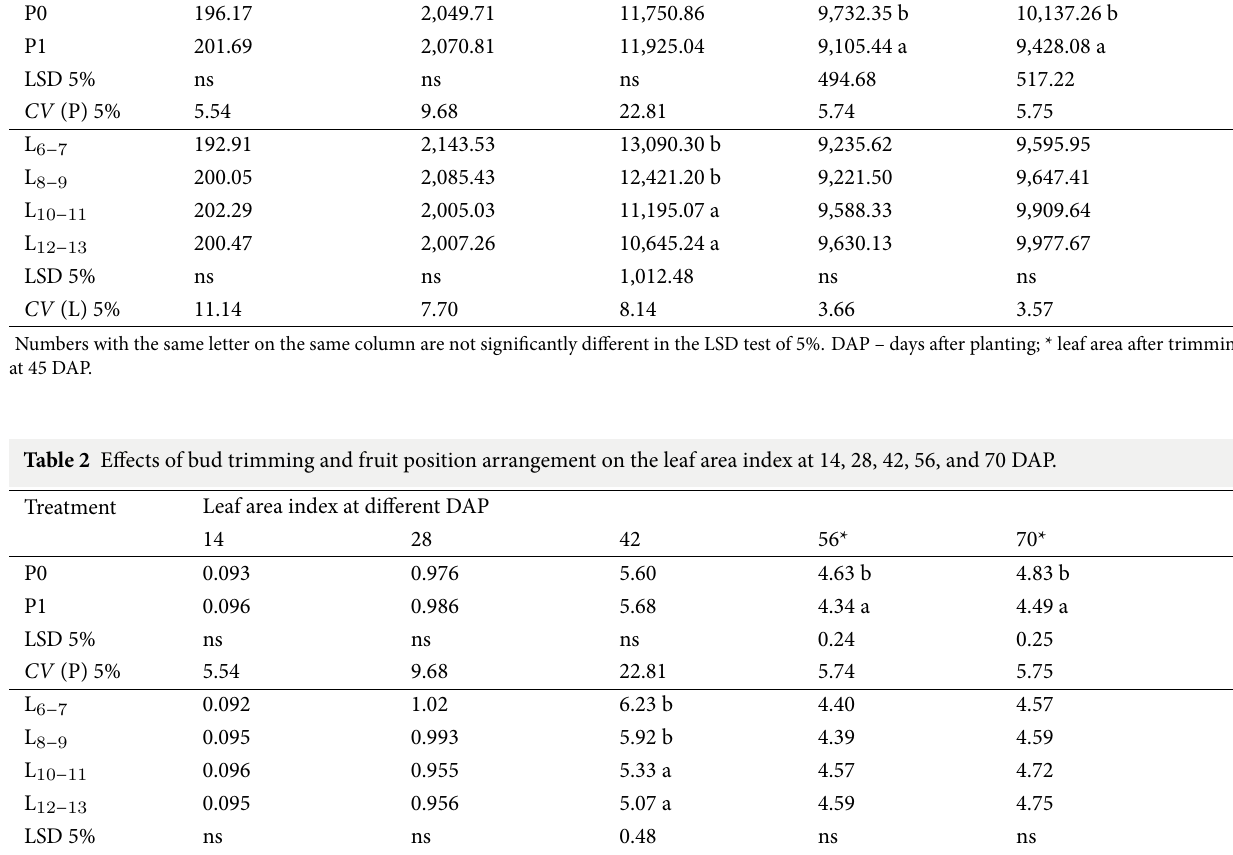
Table 1 Effects of bud trimming and fruit position arrangement on the leaf area per plant at 14, 28, 42, 56, and 70 DAP. Treatment